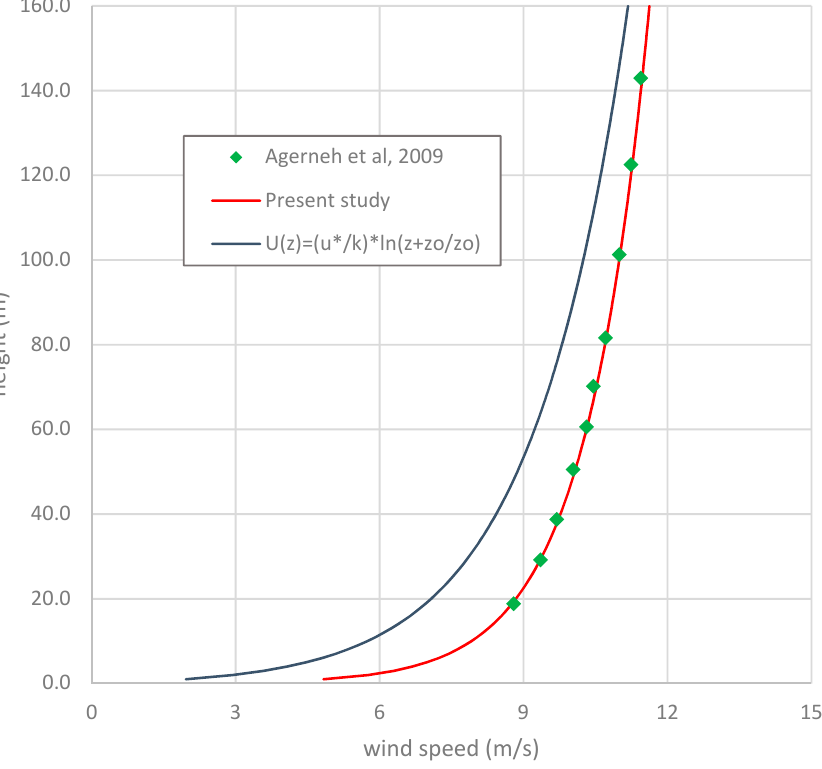
Figure 3. Inlet velocity profile used in the present study.